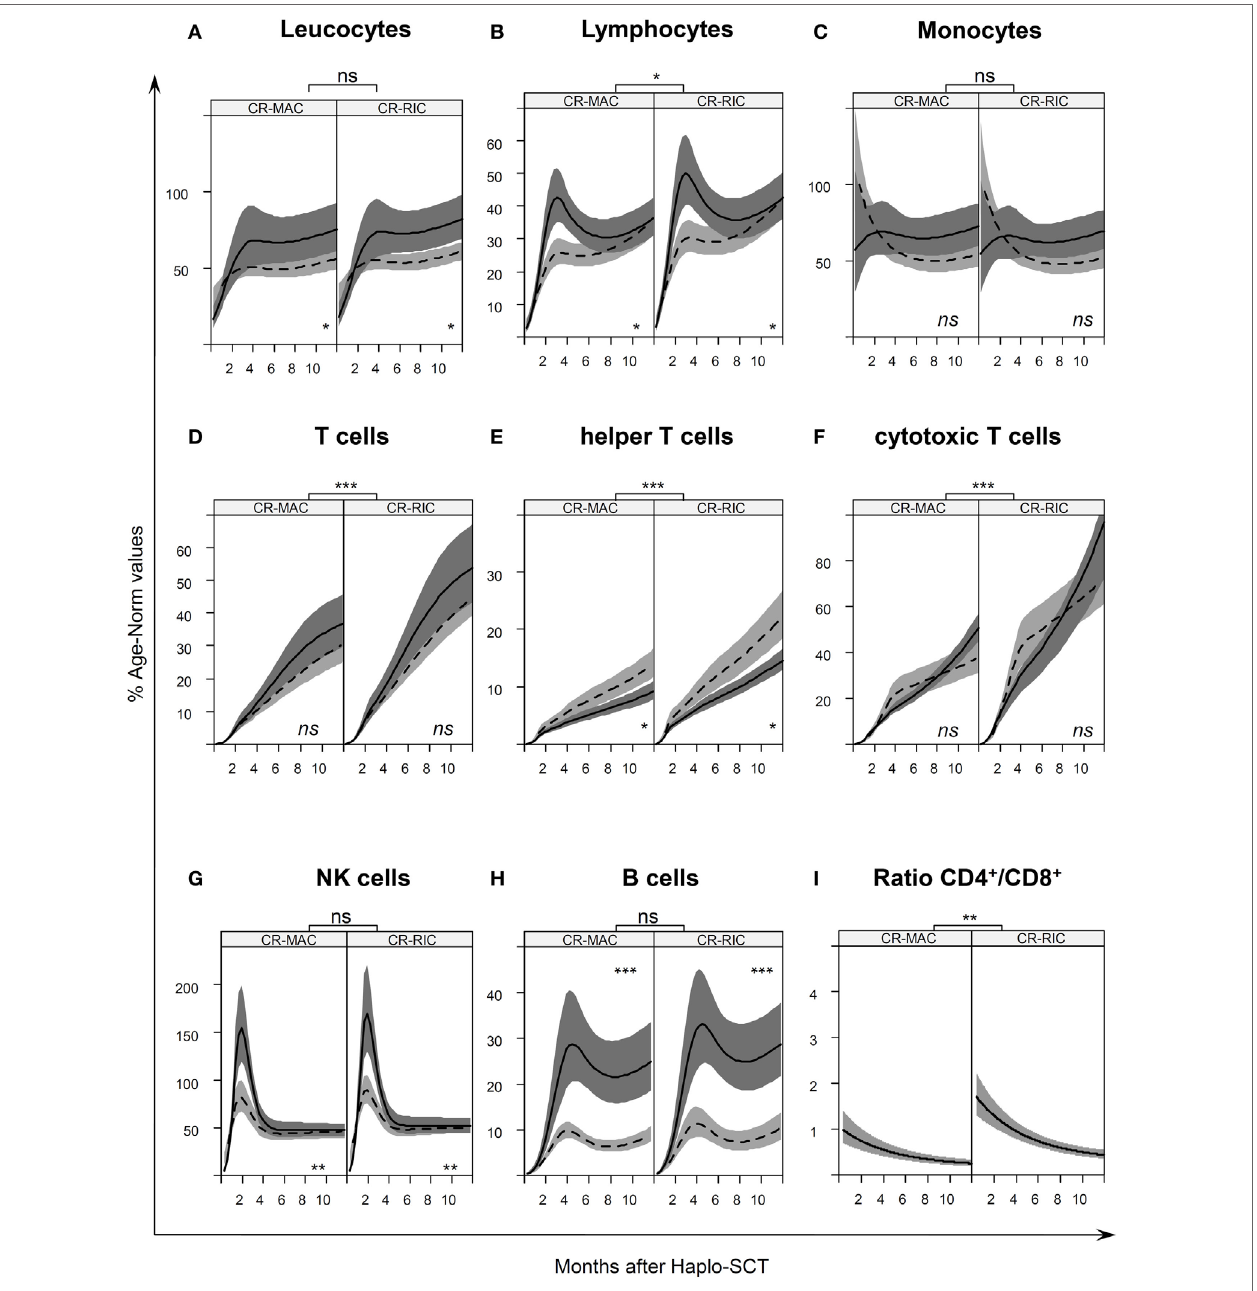
FigUre 2 | Age-normalized immune reconstitution (IR) in the first year after haplo-stem cell transplantation (SCT) IR normalized by age-specific norm values (27) Table S1 in Supplementary Material, of (a) leukocytes, (b) lymphocytes, (c) monocytes, (D) T cells, (e) helper T cells, (F) cytotoxic T cells, (g) natural killer, and (h) B cells in the first year after transplantation. The curves illustrate the splines of the longitudinal trajectory of IR after SCT based on our joint models with point wise 95% confidence regions. The CR-MAC and CR-RIC panels (left and right panel, respectively) exhibit the predicted IR for patients in any remission prior to SCT according to the type of graft PBSC CD34sel (solid line with dark gray confidence regions) or PBSC CD3/CD19dep (dashed line with light gray confidence regions). (i) CD4/CD8 ratio of the absolute cell count of CD4 + helper T cells and CD8 + cytotoxic T cells at different time points after SCT. See also Figure S1 in Supplementary Material for a representation of absolute numbers for predicted values for a 10-year-old child. ns, not significant; * P < 0.05; ** P < 0.01; *** P <